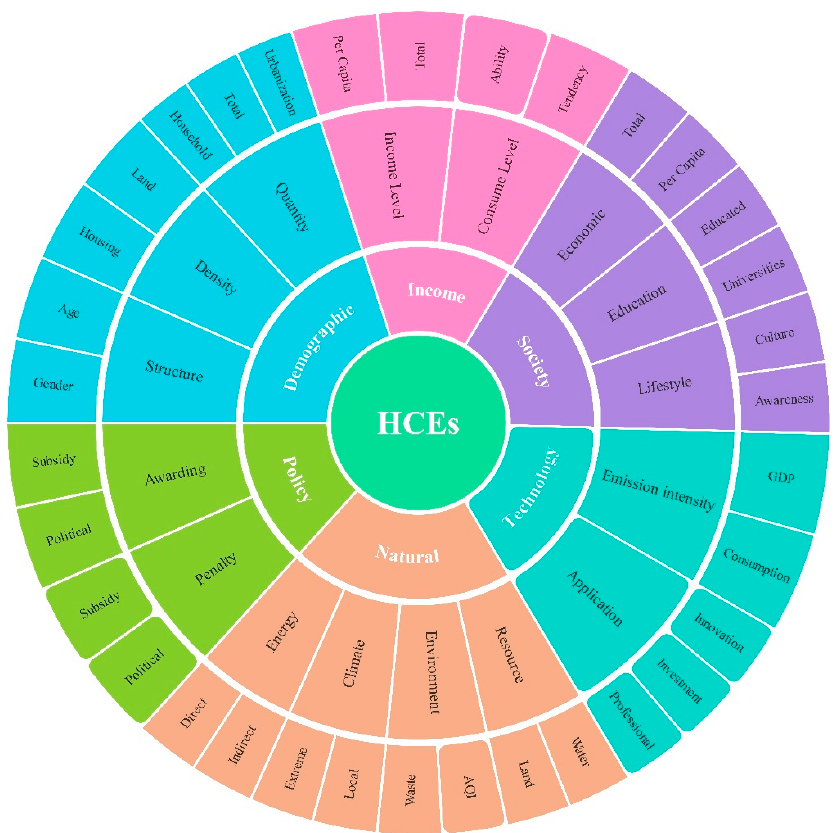
Figure 7. The main influencing factors of HCEs.